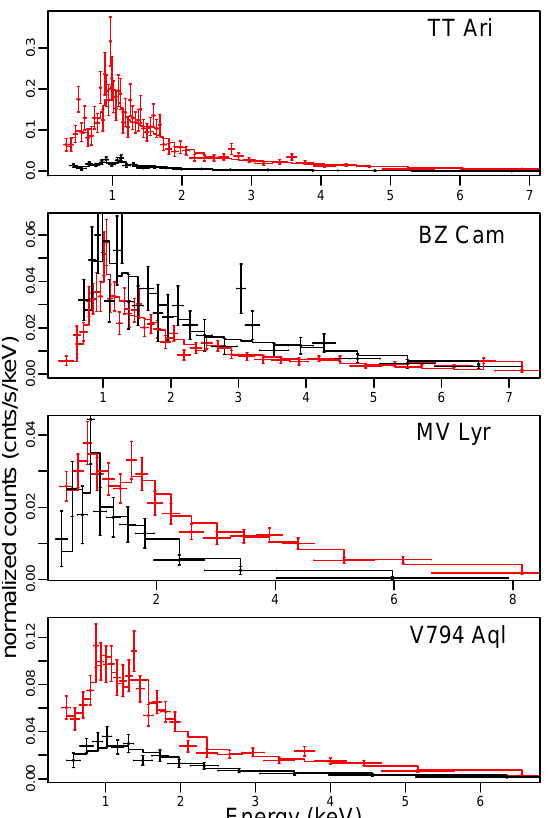
Figure 1: The low and high states X-ray spectra of BZ Cam and MV Lyr observed with Swift . TT Ari and V794 Aql were observed with Swift during the low and intermediate states. The high and intermediate state spectra are plotted in red and the low state spectra in black. The solid lines show the spectral fits, the dots with error bars are the data points.